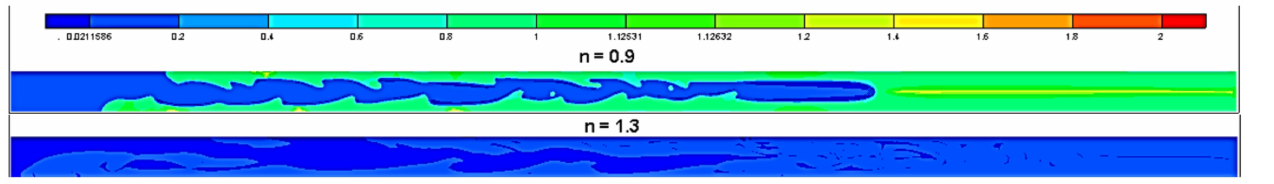
Figure 10. The viscosity contour for different